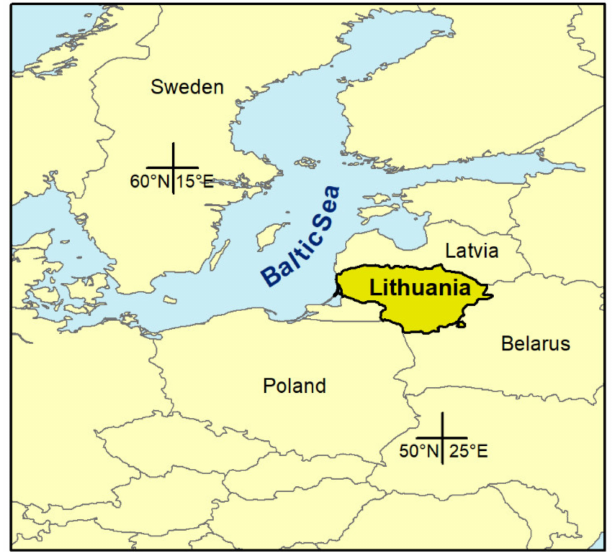
Figure 1. Location of the study area. Source of the data used: https://thematicmapping.org/ downloads/world_borders.php (accessed on 22 March